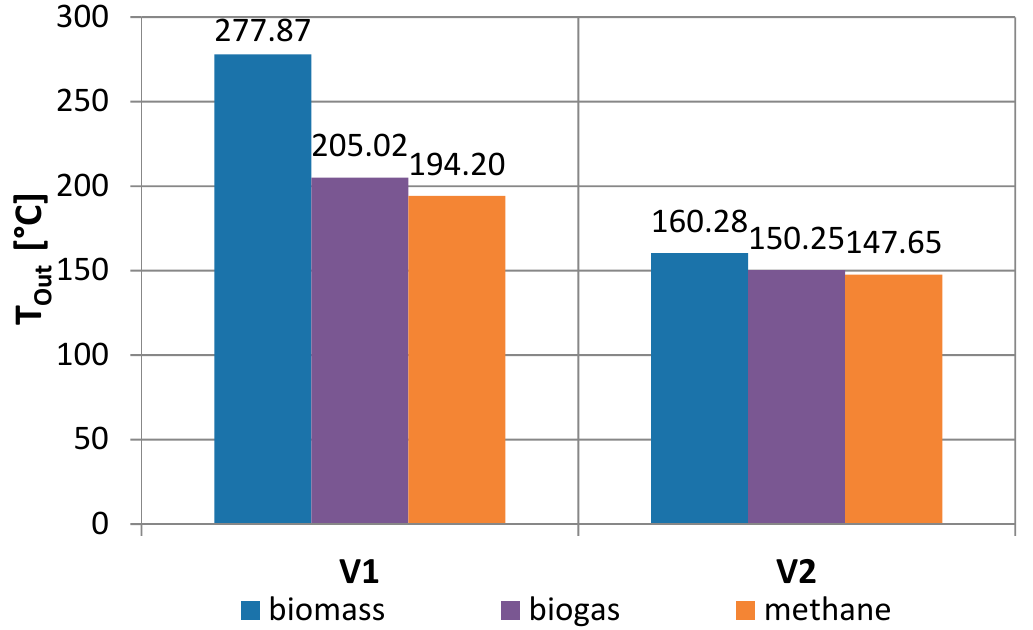
Figure 11. The influence of the calorific value of the fuel and the structure of the cycle on temperature of exhaust gas leaving the turbine set.